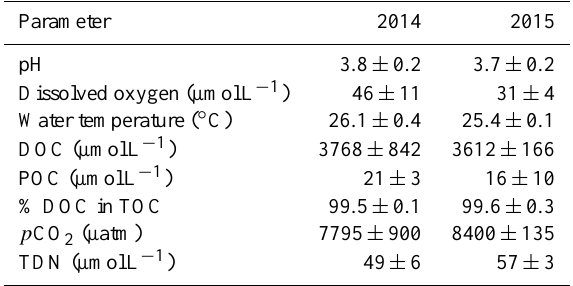
Table 1. Median values ± 1SD for the main parameters measured in the Maludam River (samples from inside the national park only).